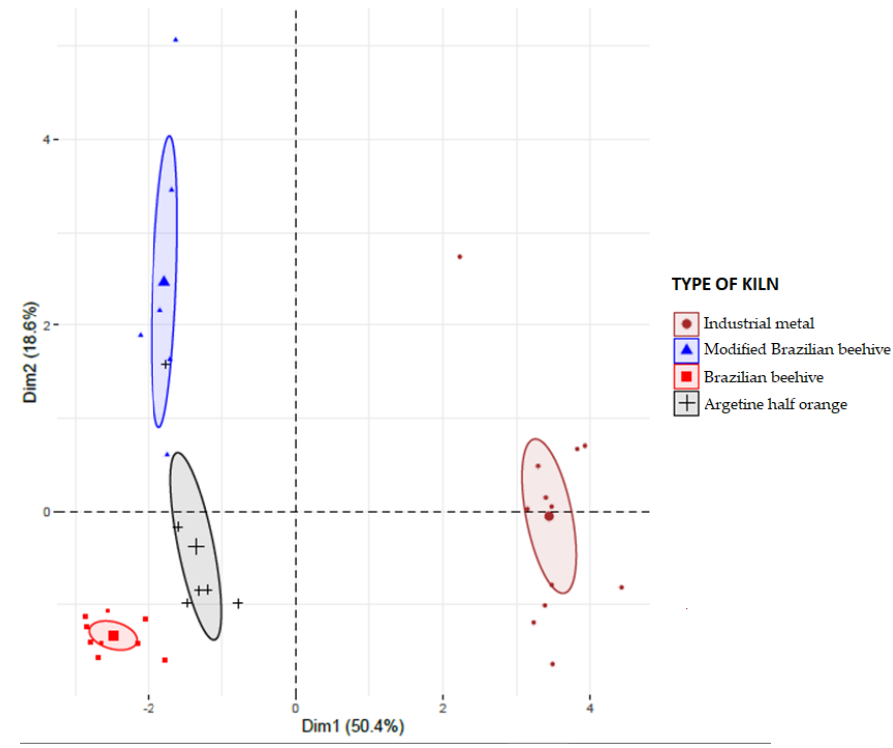
Figure 14. Grouping of the variable’s representative of the carbonization process.